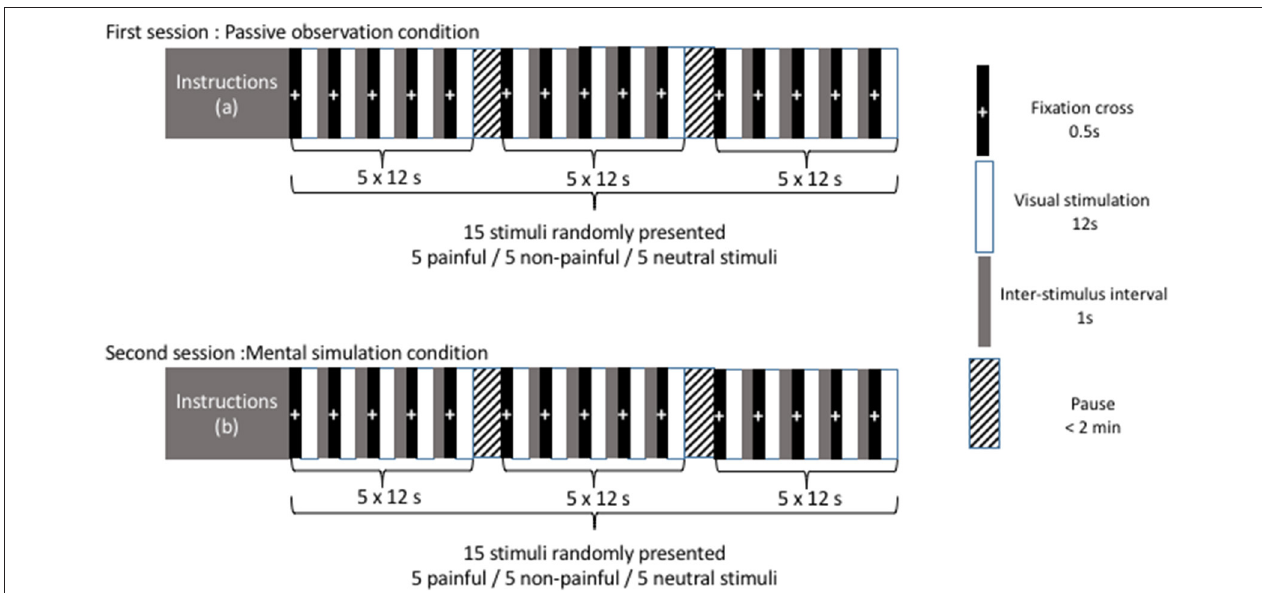
FIGURE 1 | Presentation of pictures and timing. Instructions (a) maintain a comfortable bipedal stance and remain as motionless as possible without any voluntary movements. Instructions (b) maintain a comfortable bipedal stance and remain as motionless as possible without any voluntary movements. Imagine that you are personally experiencing the situations you are about to see.